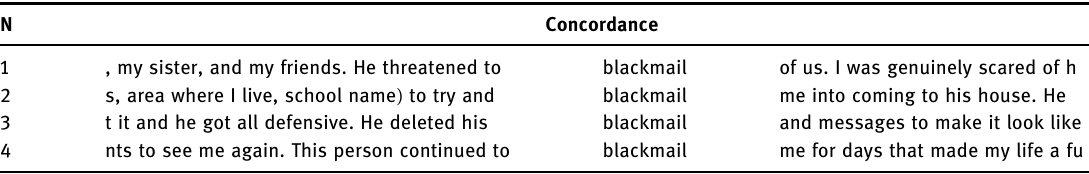
Table 38: Concordance lines for blackmail